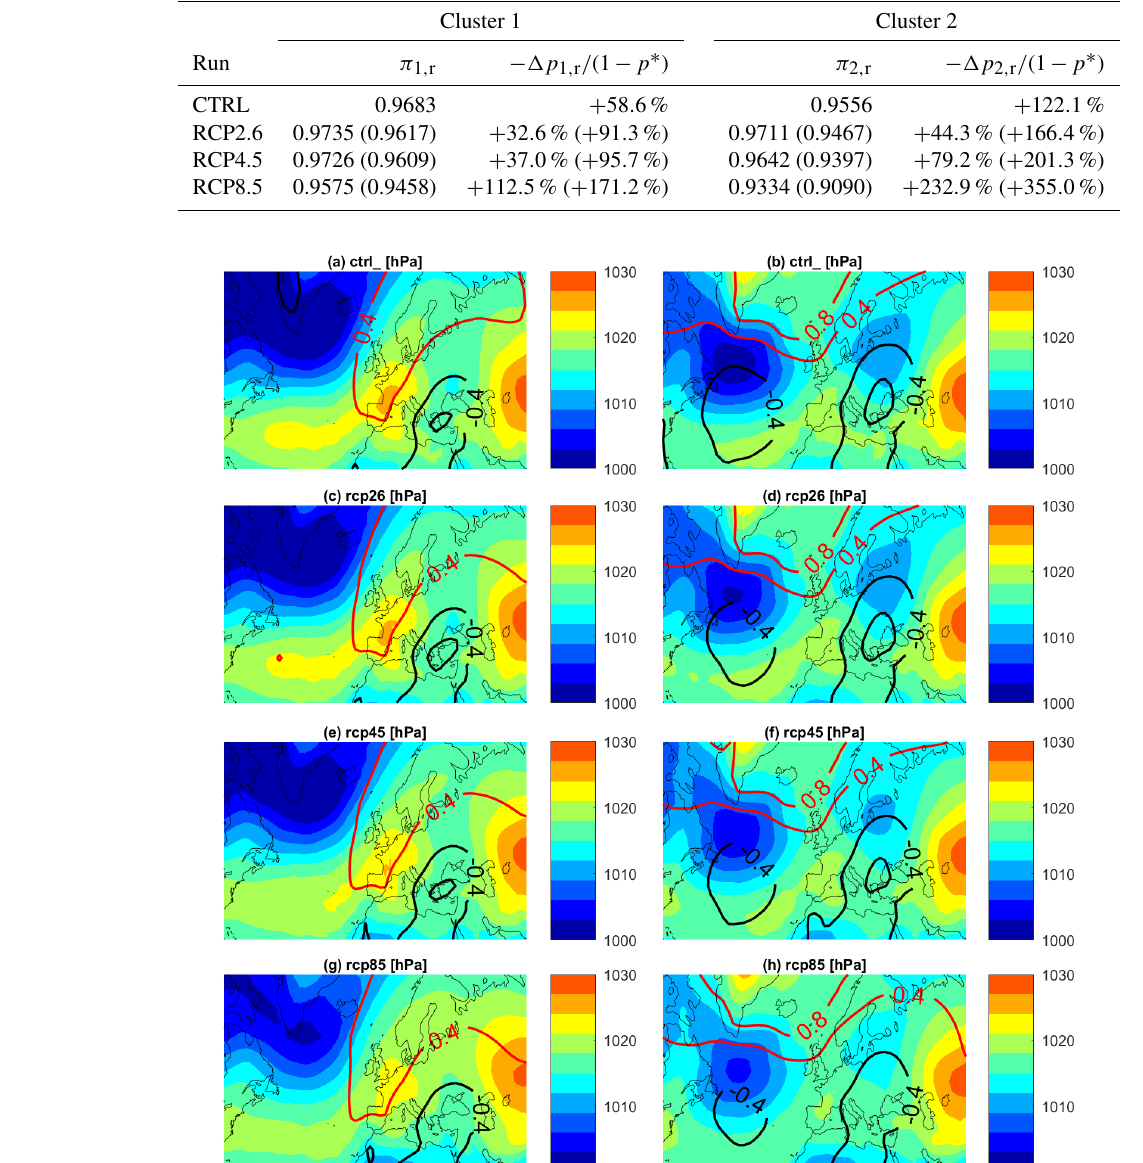
Figure 7. Sea-level pressure in PlaSim simulations: average of the sea-level pressure [hPa] for cluster 1 (a, c, e, g) and cluster 2 (b, d, f, h) of analogues. (a, b) Control run. (c, d) RCP2.6 run. (e, f) RCP4.5 run. (g, h) RCP8.5 run. Isolines represent positive (in red) and negative (in black) standardized